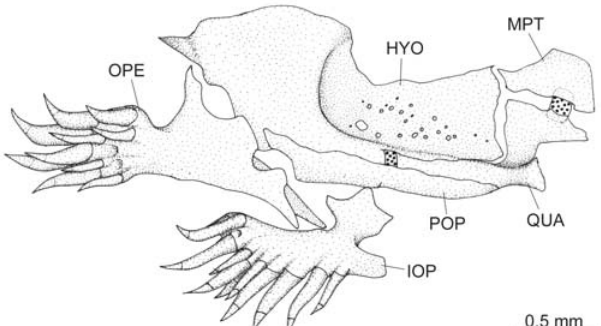
Fig. 4. Suspensorial and opercular series of Ituglanis macunaima , paratype, MZUSP 86251 (25.5 mm SL), lateral view of right side. Abbreviations: HYO, hyomandibula; IOP, interopercle; MPT, metapterygoid; OPE, opercle; POP, preopercle; QUA,